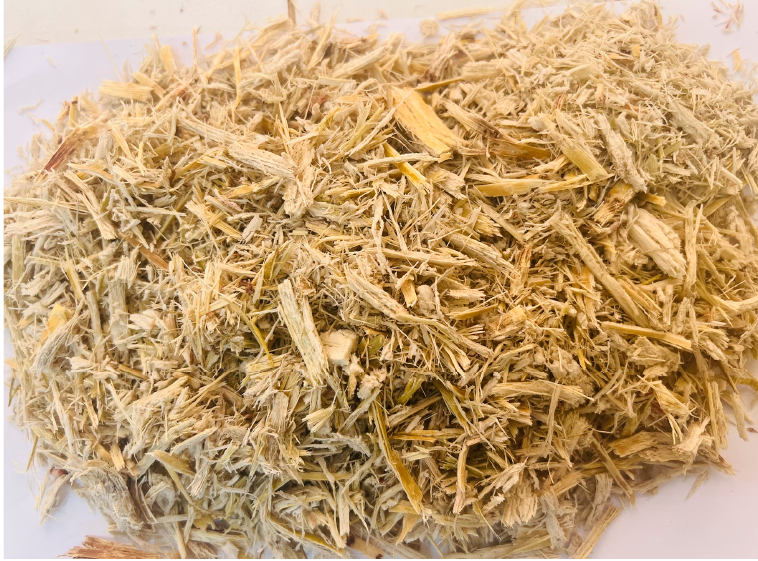
Figure 1. Sugarcane bagasse